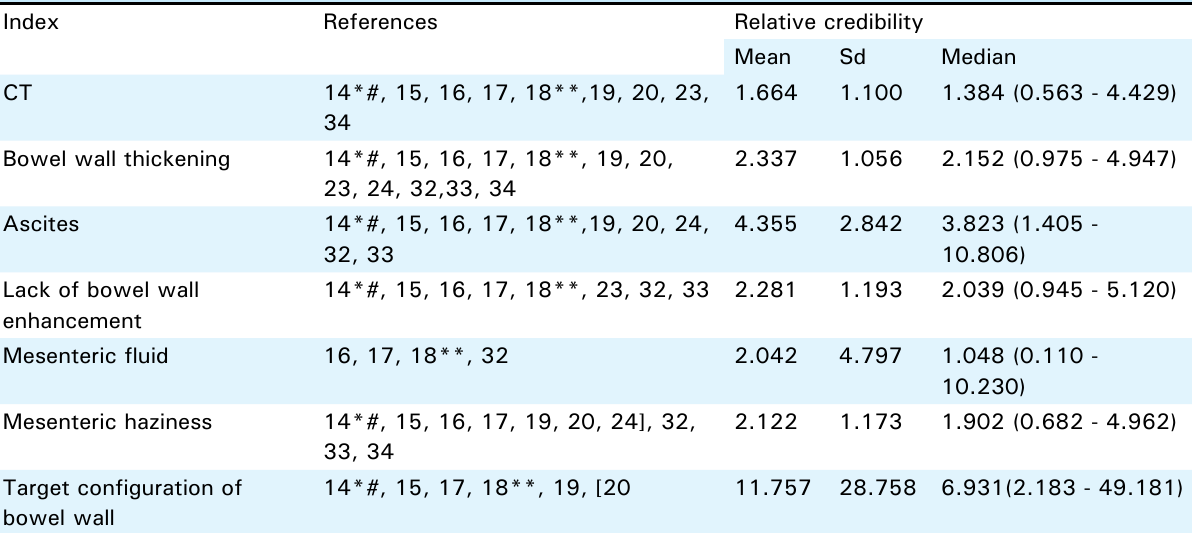
table 4. collective data of comparison of prospective and retrospective